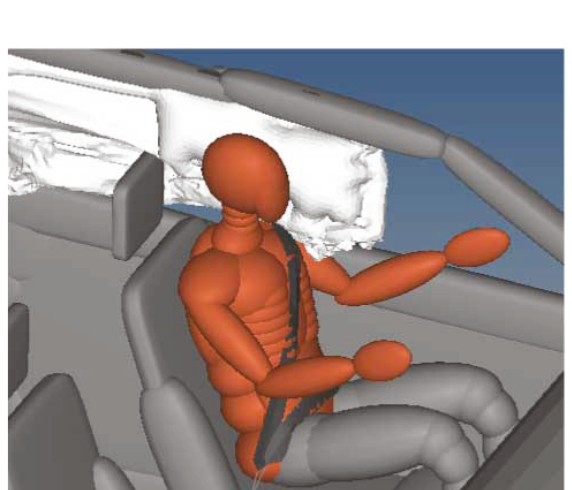
Figure 13: Contact between the head and curtain airbag at